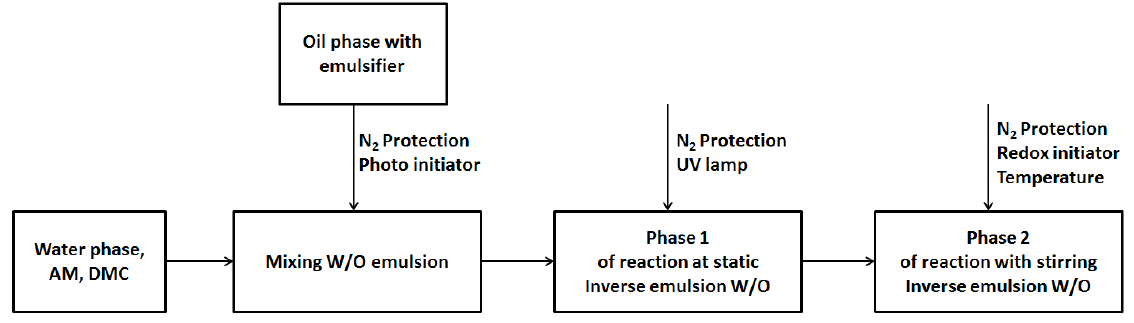
Figure 1. CPAM synthesis process.